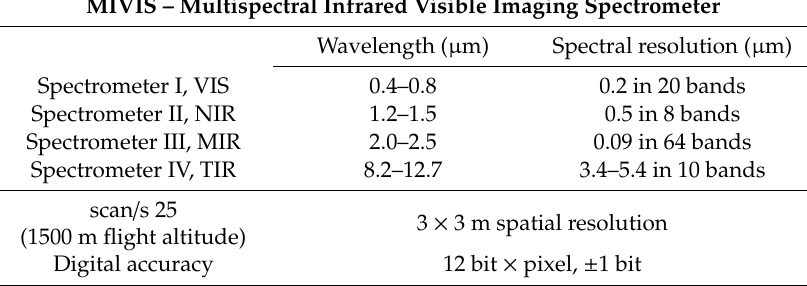
Table 1 . Main technical features of topographic LiDAR sensor. Table 2. Technical features of hyperspectral MIVIS